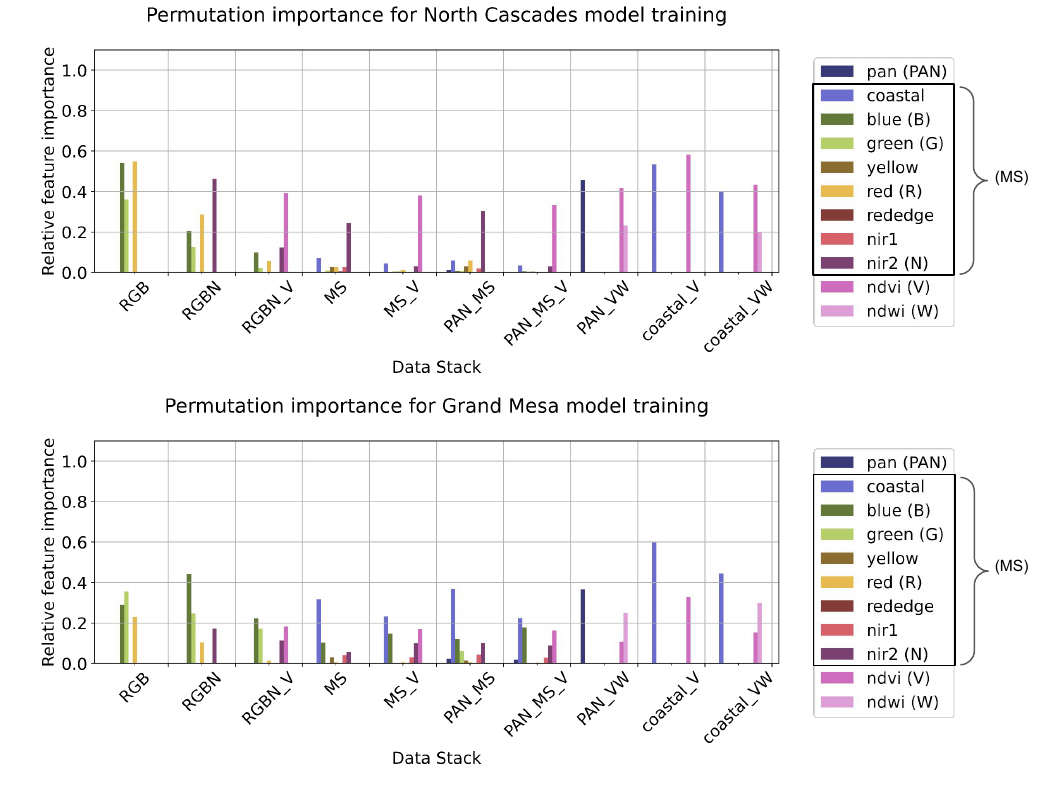
Figure 5. Permutation importance (mean decrease in accuracy [MDA]) for single-scene models with variable input data layer configurations (Table 2) using images acquired on ( a ) 20 May 2015 at the North Cascades site and on ( b ) 26 March 2019 at the Grand Mesa site. NDVI is consistently important (as is the NIR2 band, especially in the absence of NDVI), and the coastal blue band is important compared to other multispectral (MS)